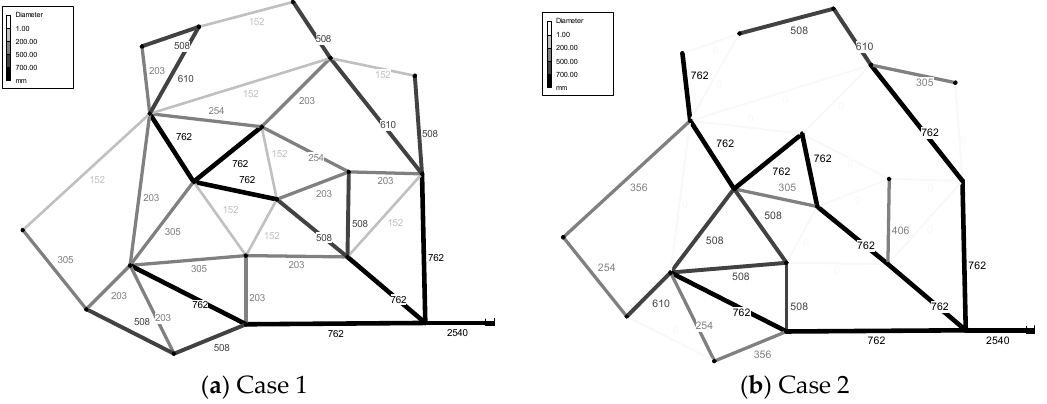
and more loops would result in the increase of system reliability and redundancy [11,60]. However, the result of this study indicates that a different strategy should be available under the conditions where